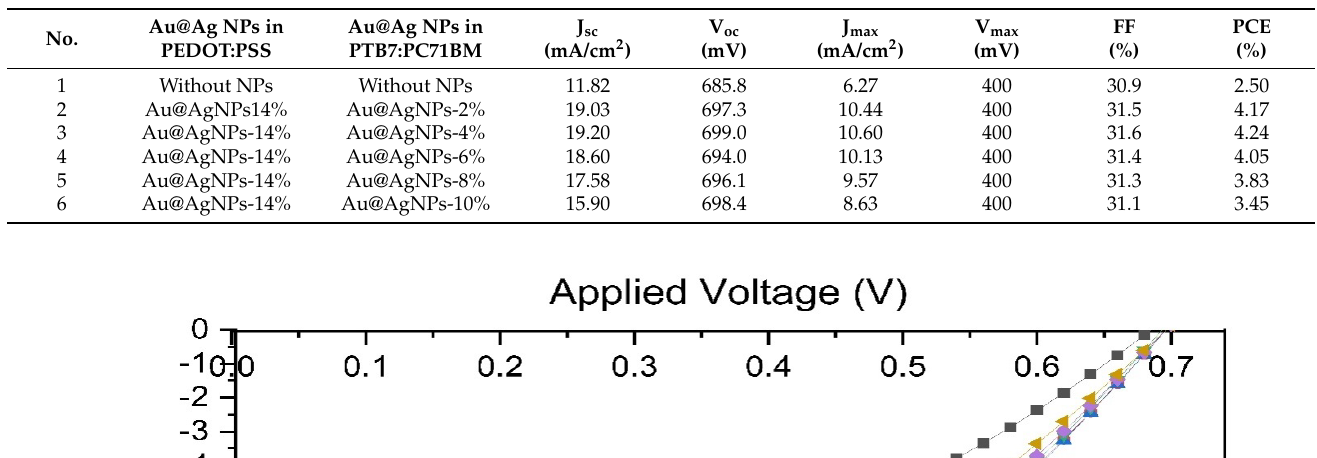
Table 1. Electrical parameters of the PSCs with and without NPs.